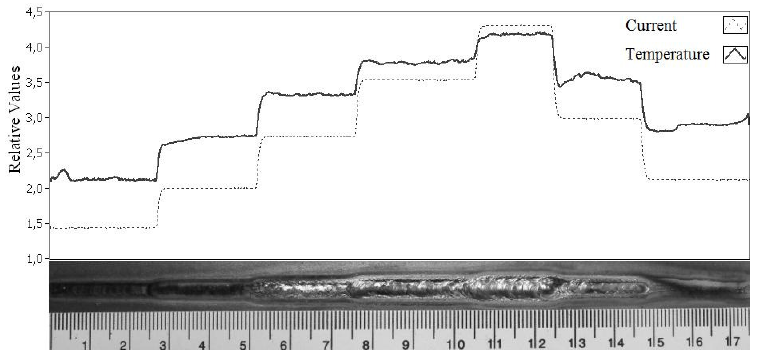
Figure 6. Temperature behavior with currents varied.